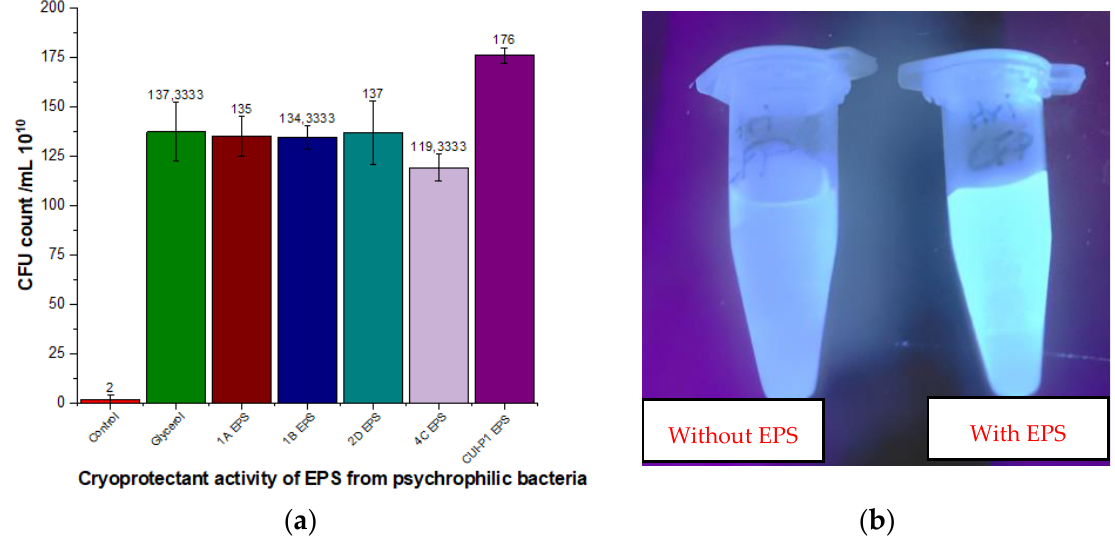
Figure 2. ( a ) Cryoprotectant activity of EPS isolated from psychrophilic bacteria in comparison with glycerol and control. ( b ) Cryoprotective role for CUI-P1 EPS in increasing the shelf life of E. coli strain caging HriGFP protein.